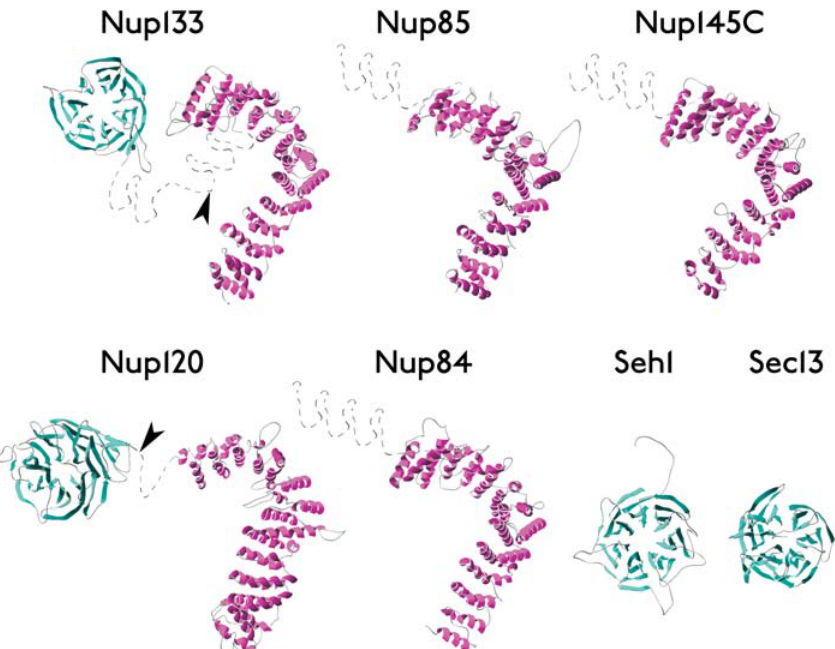
Figure 1. Ribbon Representation of Nup Models b -sheets ( b -propellers) are colored cyan and a -helices ( a -solenoids) are colored magenta. Gray dashed lines indicate regions that were not modeled. Arrow- heads indicate the positions of high proteolytic susceptibility (see Figures 2 and 3). DOI: